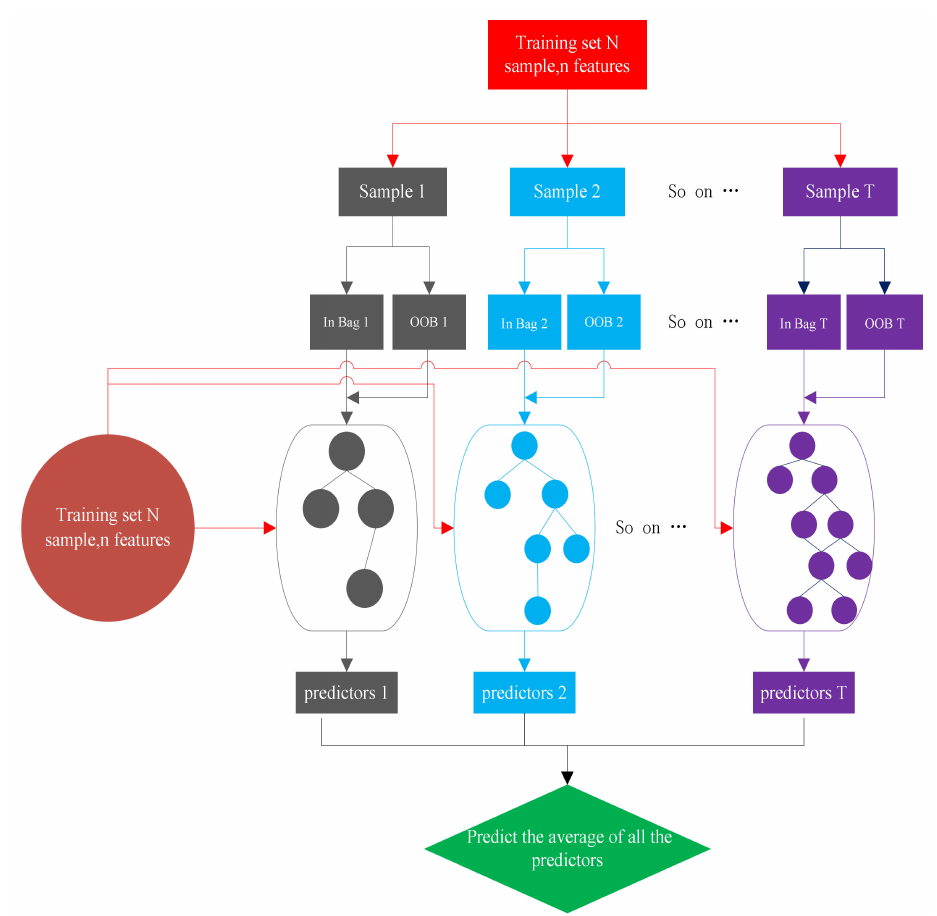
Figure 2. General architecture of the random forest